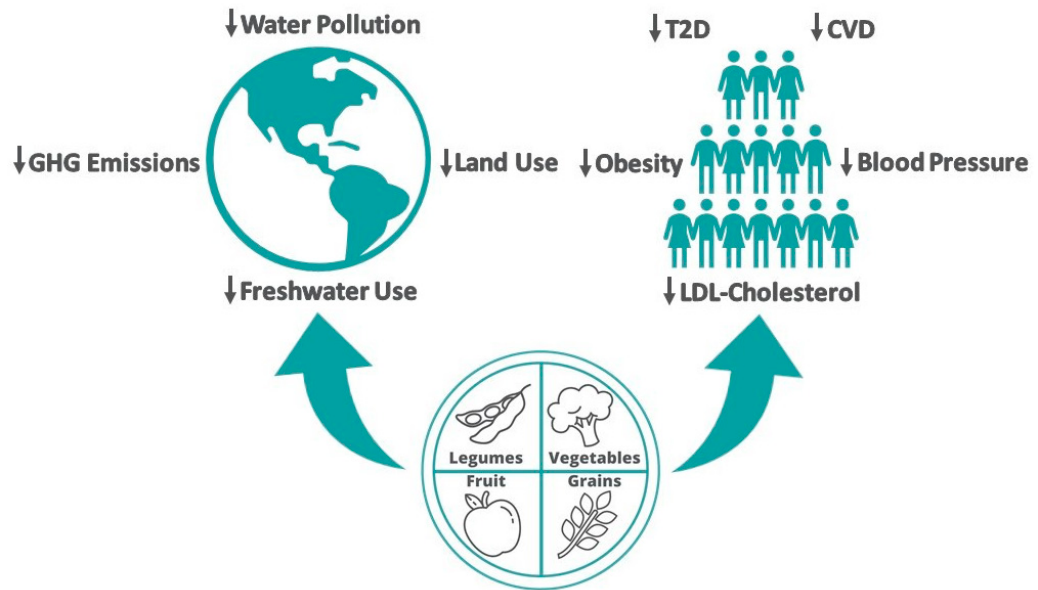
Figure 1. Summary of the planetary and human health benefits associated with the adoption of plant-based dietary patterns. Abbreviations: CVD, cardiovascular disease; GHG, greenhouse gas; LDL, low-density lipoprotein; T2D, type 2 diabetes.